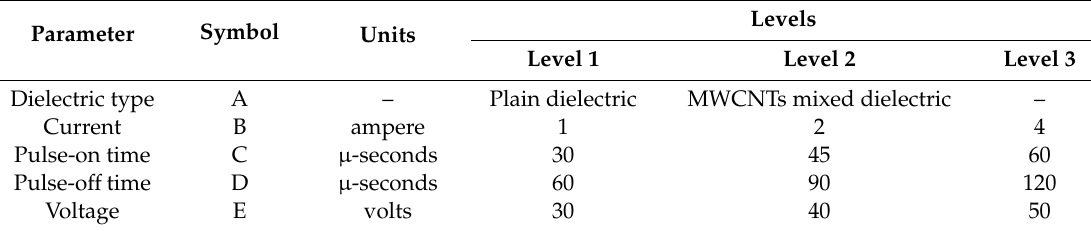
Table 3. Experimental process parameters with their respective levels.